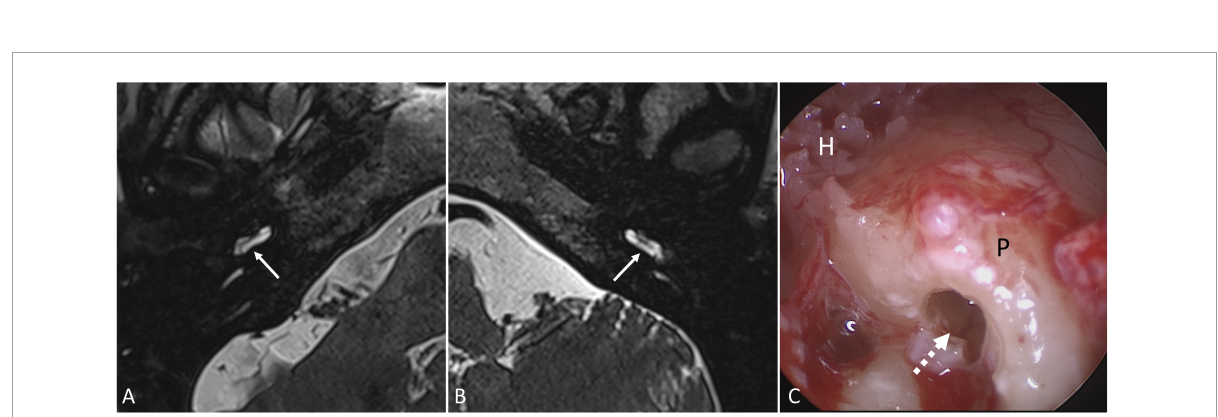
FIGURE8 Magnetic resonance imaging (T2-weighted 3D-SPACE, axial, 0.4 mm) showing the basal cochlear turn of patient No. 17 (A) 6 months and of patient No. 16 (B) 9 months after intracochlear implantation of Ozurdex R (cid:13) into the basal part of scala tympani. Regular fluid signals were found in the scala tympani of the basal turn ( → ) and in the entire inner ear without pathologic contrast enhancement and without signs of implant residuals (Department of Radiology, University Medicine Halle, Sabrina Kösling with permission). On cochlear implantation of patient No. 16, no signs of inflammation, foreign body reaction or residuals of the implant were found in the basal part of scala tympani (dashed arrow) (C) . H: hypotympanon; P: